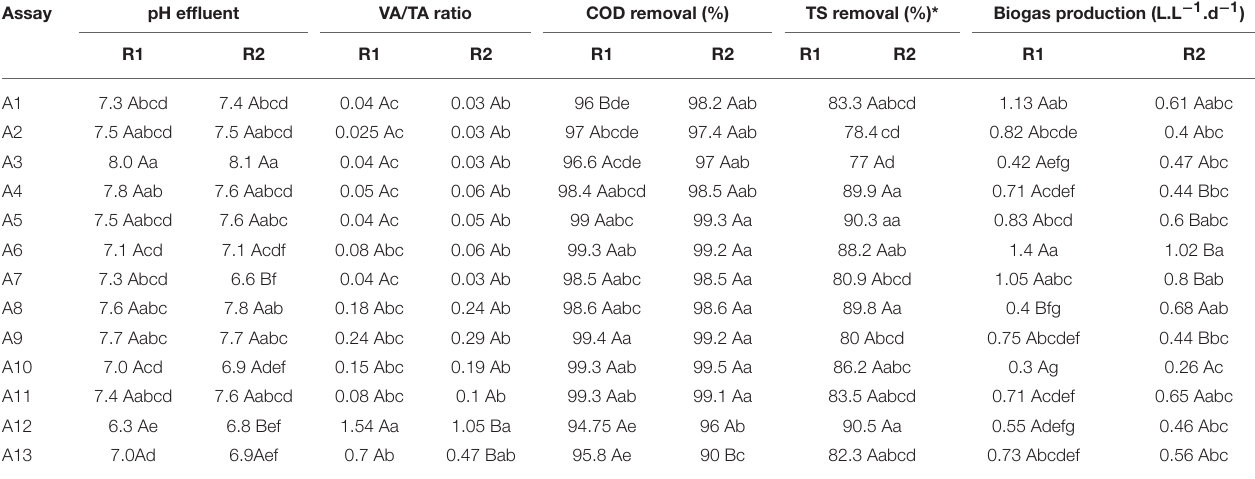
TABLE 2 | Performance indicators.